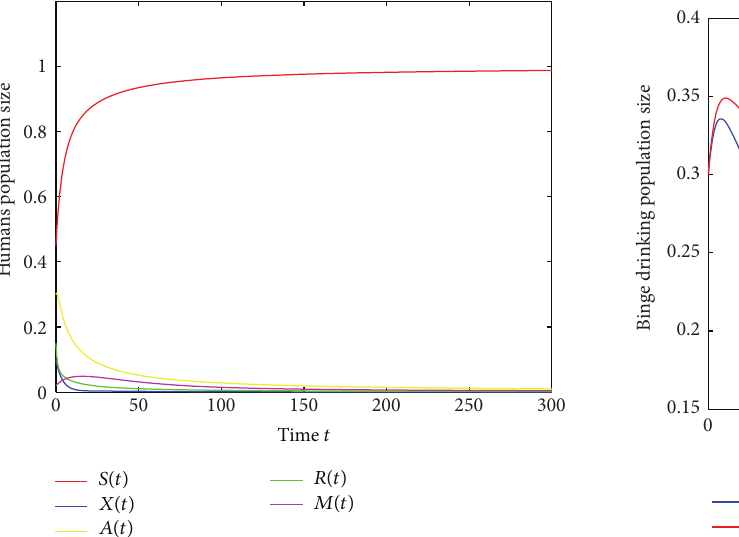
Figure 3: If 𝑅 0 = 1 , the alcohol free equilibrium 𝐸 0 is globally asymptotically stable.